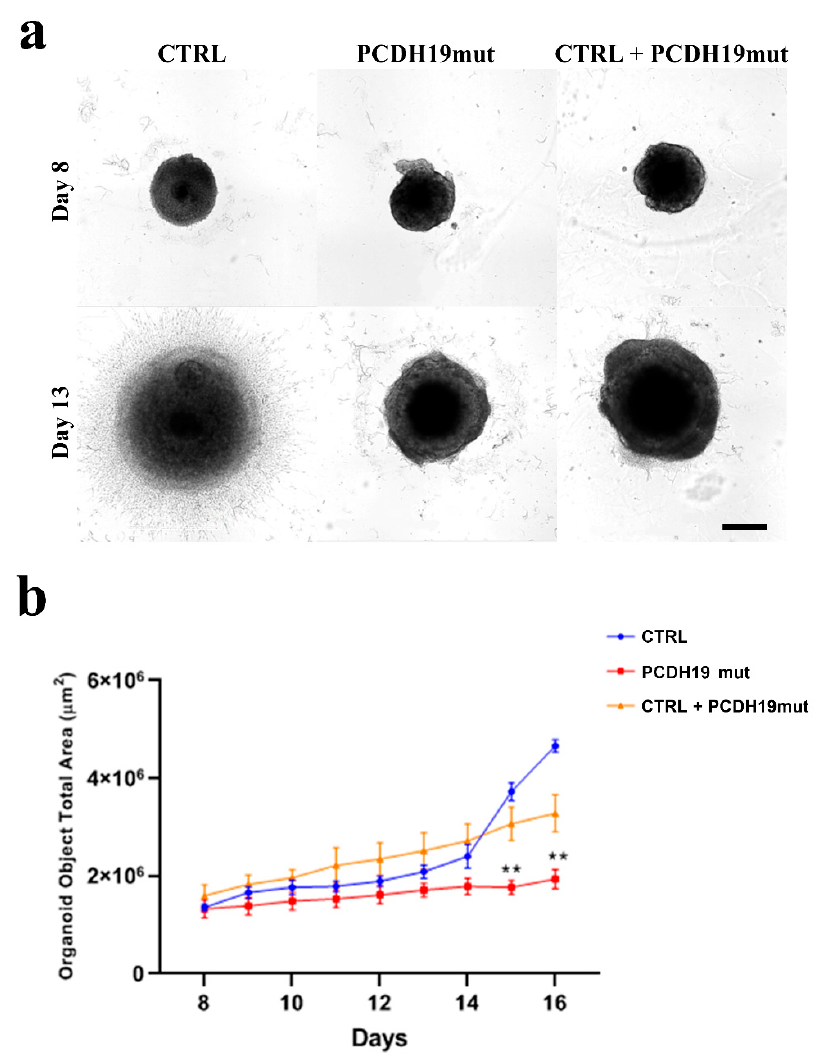
Figure 7. Brain organoids derived from CTRL, PCDH19mut and mixed iPSCs. ( a ) Brightfield images showing brain organoids at early stages of formation (from 8 to 13 days in vitro); ( b ) Graph representing the analysis of brain organoid size from the 8th day to the 16th day. Three organoids for each sample have been analyzed. Data are presented as mean ± SEM, n = 3. ** p < 0.005, according to ordinary one-way ANOVA parametric test.